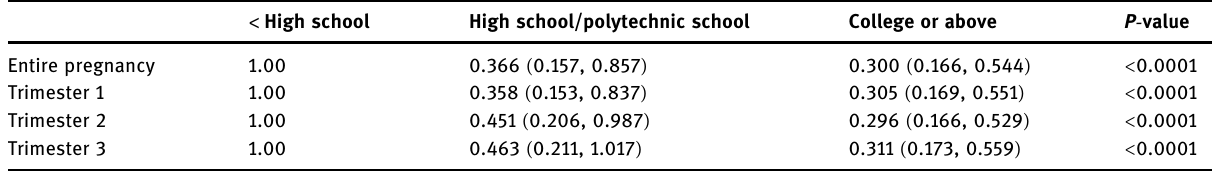
Table 2: The correlations between education levels and term low birth weight ( OR, 95% CI )